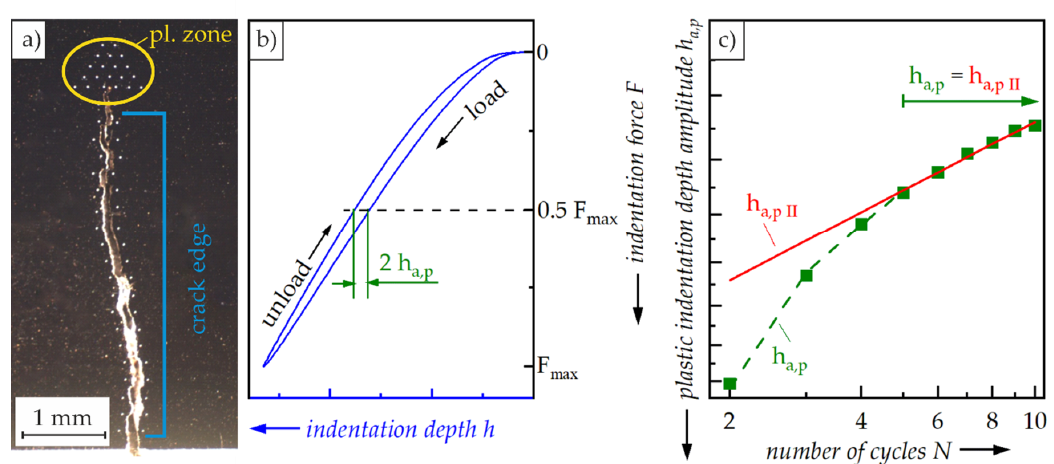
Figure 4. ( a ) Stereoscopic micrograph with indentation points at crack edges and crack tip; schematic description of ( b ) indentation force F -indentation depth h hysteresis, as well as plastic indentation depth amplitude h a,p and ( c ) h a,p. -N curves with h a,p II [13].